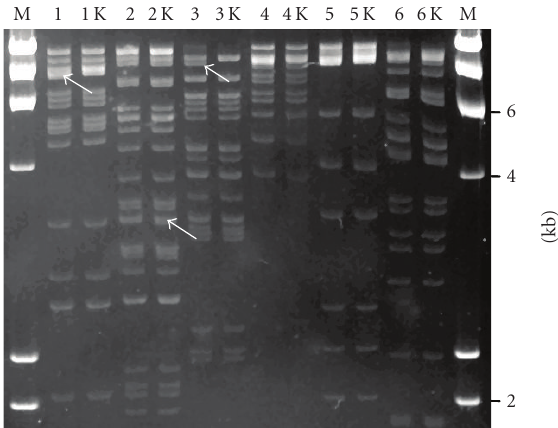
Figure 5: Fingerprinting of recombinant BAC clones. High- resolution fingerpint comparison of six targeted BAC clones with the original clones. EMS1, MGC, GRIA3, GMPPA, SKB1, and FJ20539 retrieved from the orangutan genomic library using screening by HR. Lanes 1–6 contain the original BAC clones and lanes 1 K–6K show the corresponding targeted